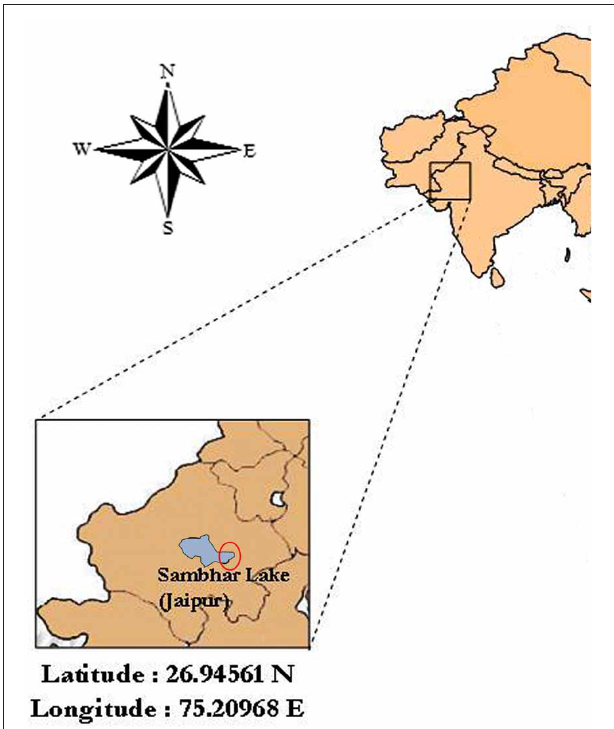
FIGURE 1 | Map of the location of the sampling site, Sambhar Salt Lake (about Latitude 26.94561N and Longitude 75.20968E), Rajasthan, India. Fairly accurate location of sampling is encircled in the